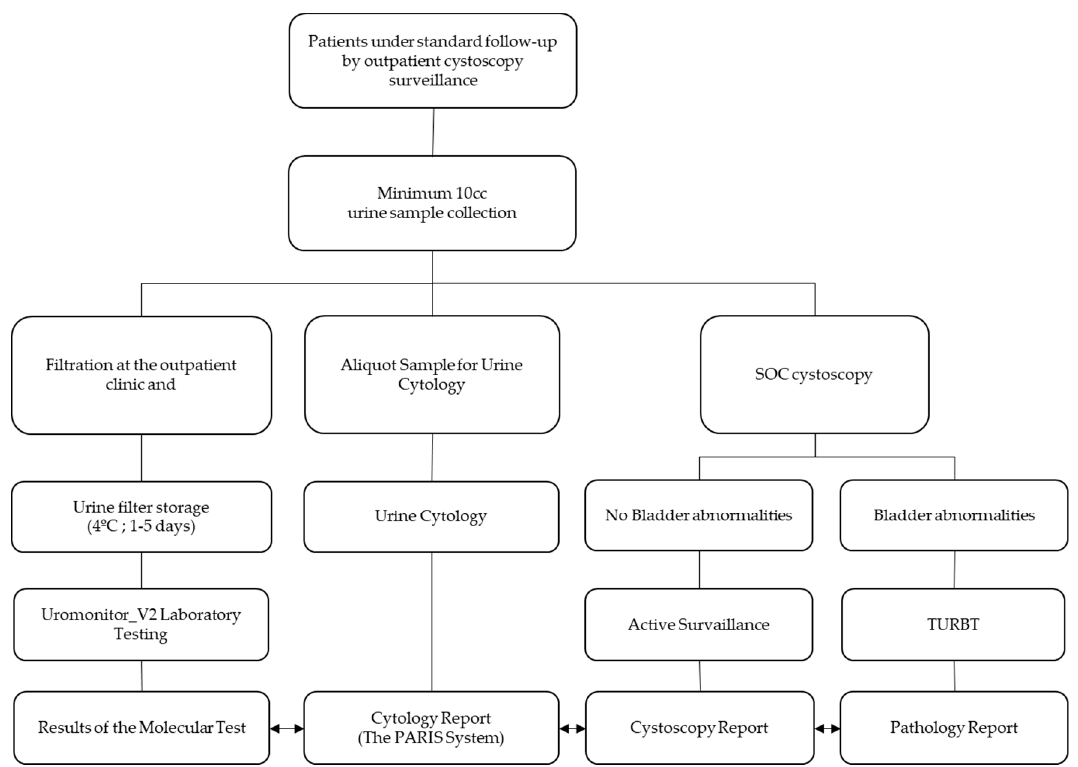
Figure 2. A visualization of the Uromonitor-V2 ® study workflow. SOC, standard-of-care; TURBT, transurethral resection of the bladder tumor.